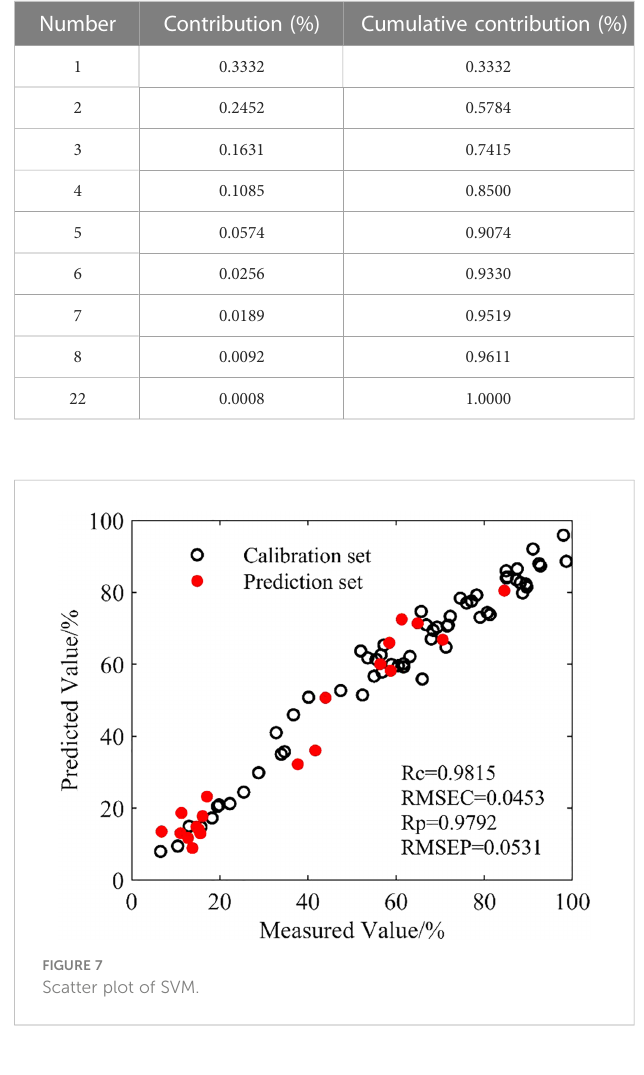
TABLE 5 Results of PCA